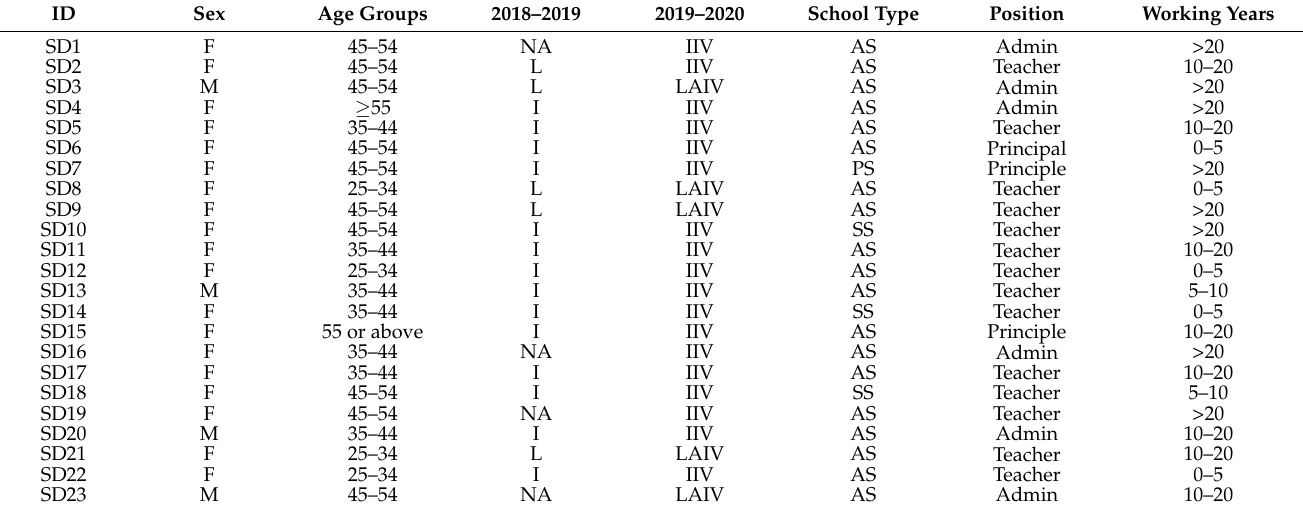
Table 2. Demographics of school personnel who participated in the in-depth interviews.